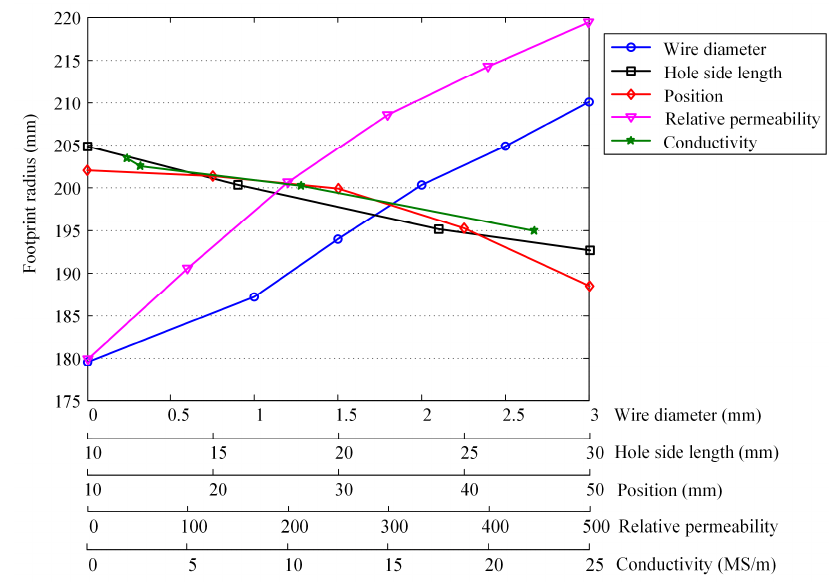
Figure 6. Plots of the probe footprint radius against the mild steel mesh